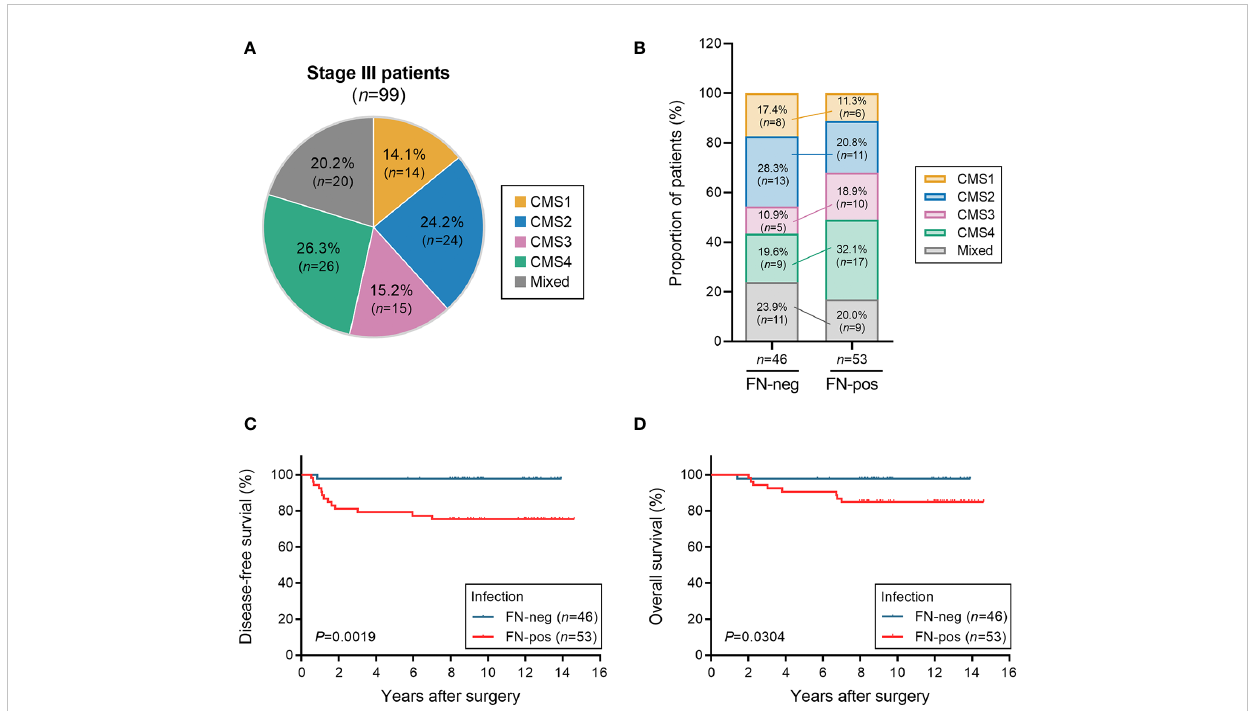
FIGURE 1 Association of FN infection, consensus molecular subtype (CMS) groups, and survival. (A) The distribution of the consensus molecular subtypes (CMS) groups in patients with stage III CRC. (B) Proportion of the CMS group in patients with CRC according to FN infection. (C, D) Disease-free survival (C) and overall survival (D) according to FN infection. Statistical tests: *P < 0.05, **P <